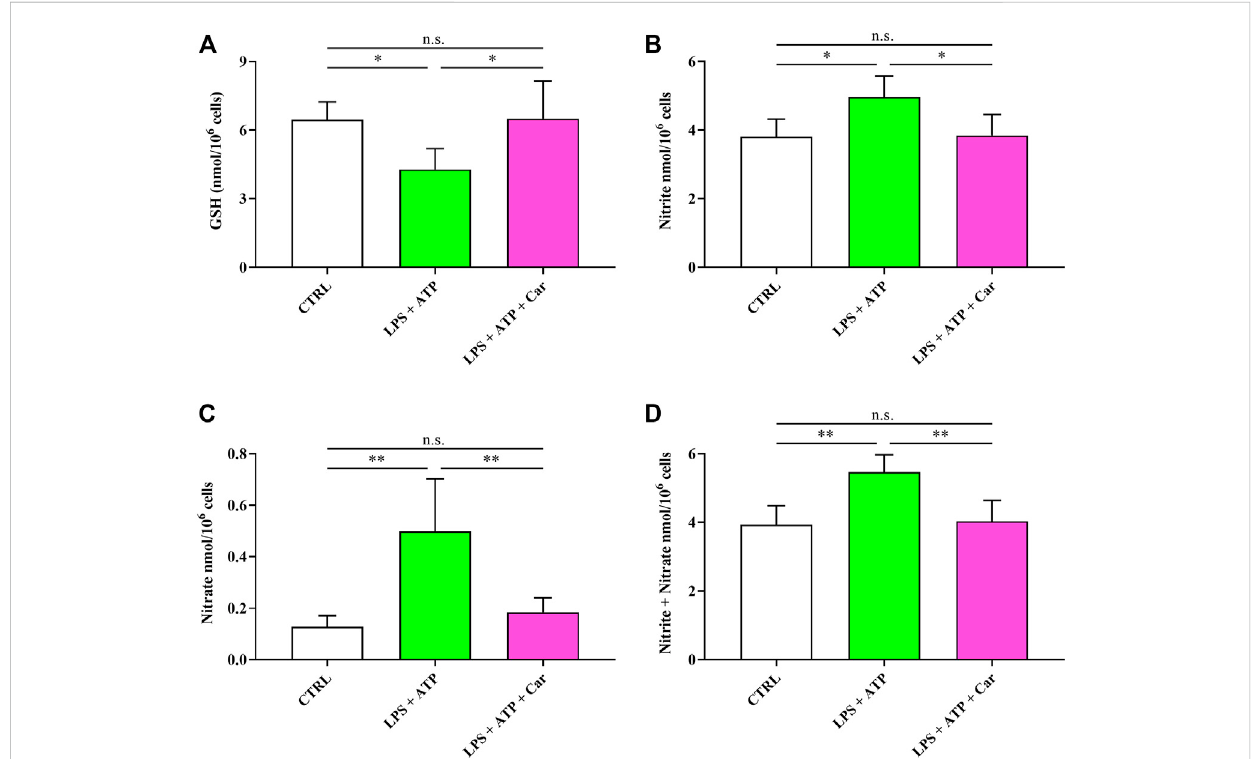
FIGURE 6 Valuesof (A) GSH, (B) nitrite, (C) nitrate,and (D) nitrite+nitratedeterminedinrestingHMC3cellsandHMC3cellsexposedtoLPS(100 ng/mL,24 h)+ ATP (5 mM, 30 min), in the absence or presence of carnosine (Car) (10 mM, 1 h pre-treatment). Data represent mean of four different samples. Standard deviations are represented by vertical bars. *Signi fi cantly different, p < 0.05; **Signi fi cantly different, p <